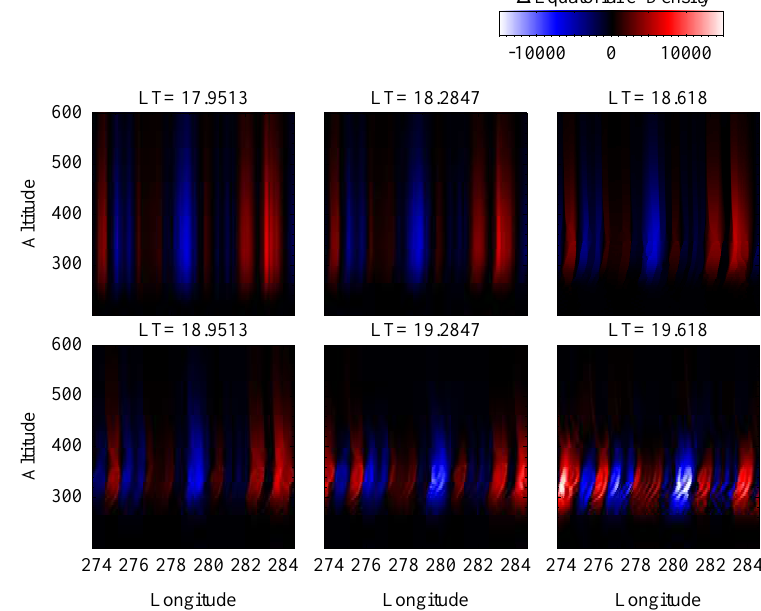
Fig. 11. Snapshots of the density perturbations taken at a sequence of times in a simulation (in number percm 3 ) in the plane of the geomag- netic equator as a function of longitude and apex altitude, beginning with the density perturbations observed by the C/NOFS satellite around 23.3 UT on day 282 of 2010 near longitude 280 ◦ (upper left plot). Time advances looking from left to right, and then continues in the lower row of plots. Modified by diffusion and shear, these perturbations do not develop into plumes; the plasma was stable at this location and